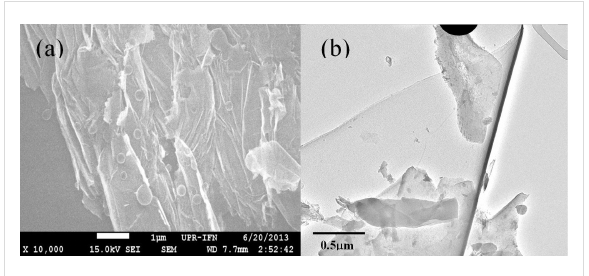
Figure 3: SEM images of BNNSs with (a) curved/wrinkle and (b) folding structure.